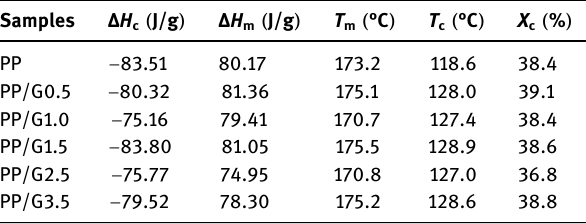
Table 3: DSC test parameters of neat PP and PP/GNP nanocomposites Samples